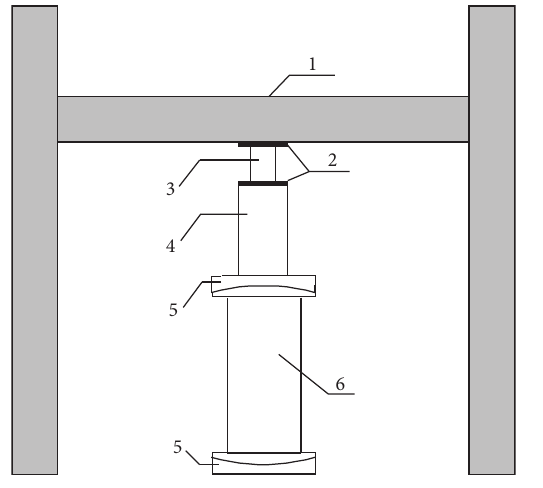
Figure 4: Loading device of specimens. (1) Reaction frame. (2) Steel plate. (3) Force sensor. (4) Jack. (5) Spherical bearing. (6)